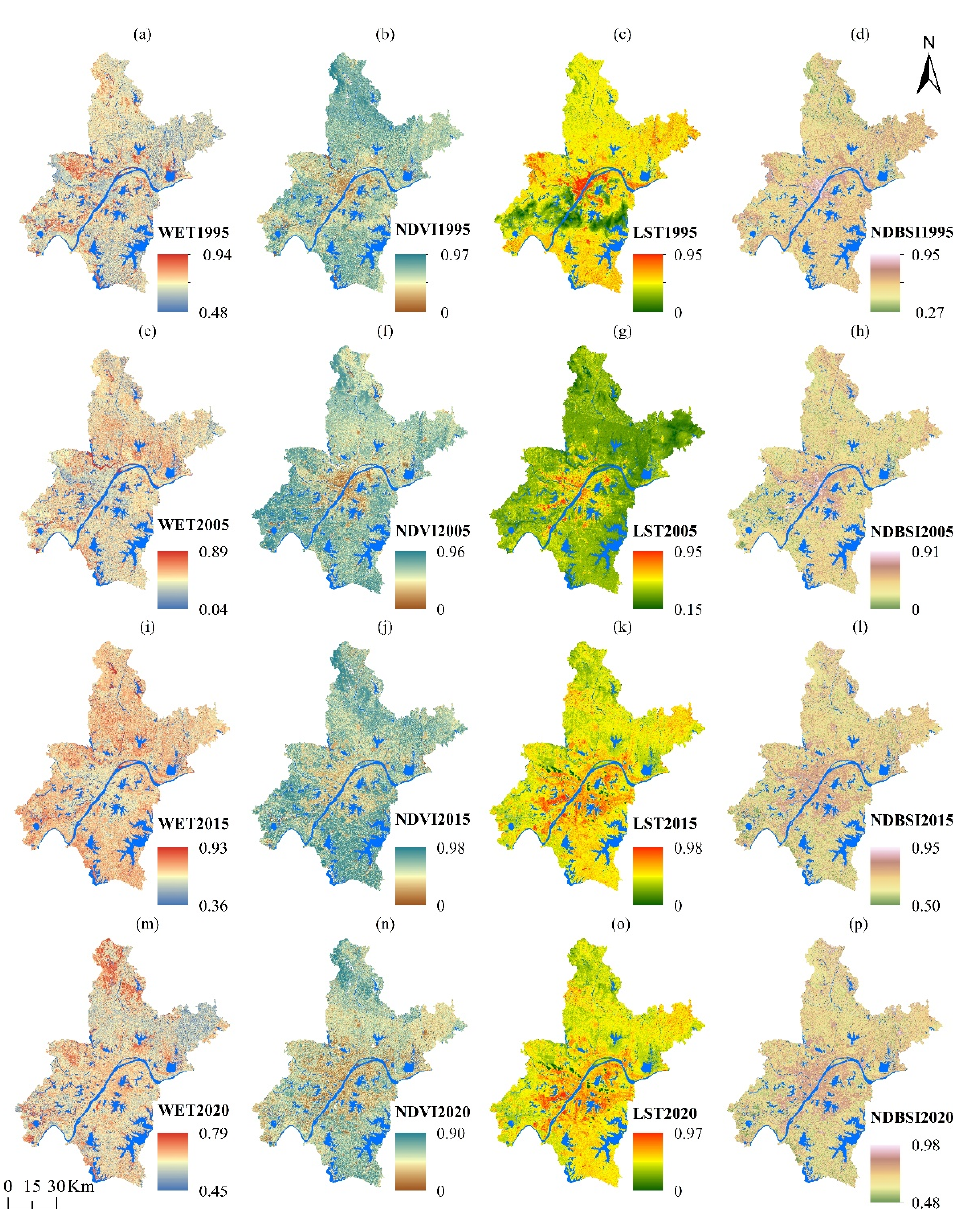
Figure 3. Spatial distribution of ecological indicators, 1995–2020. ( a – d ) indicators 1995, ( e – h ) indicators 2005, ( i – l ) indicators 2015, ( m – p ) indicators 2020.